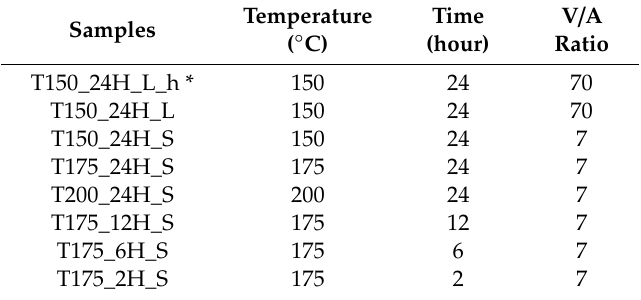
Table 1. Samples with various conditions for the hydrothermal